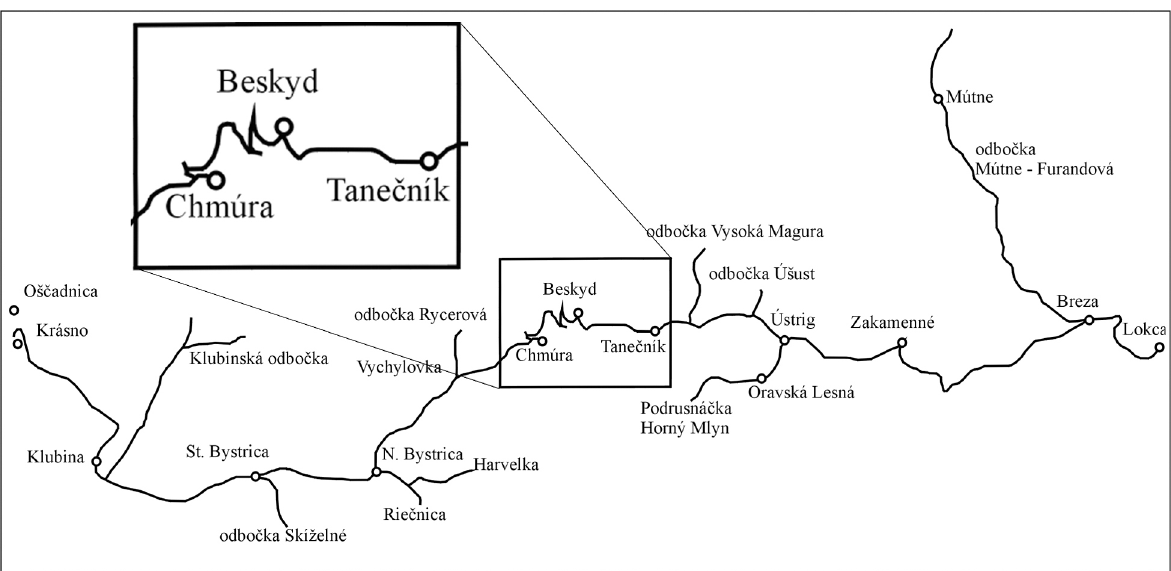
Fig. 10. Tracks of the Kysuce-Orava Forest Railway in 1926.